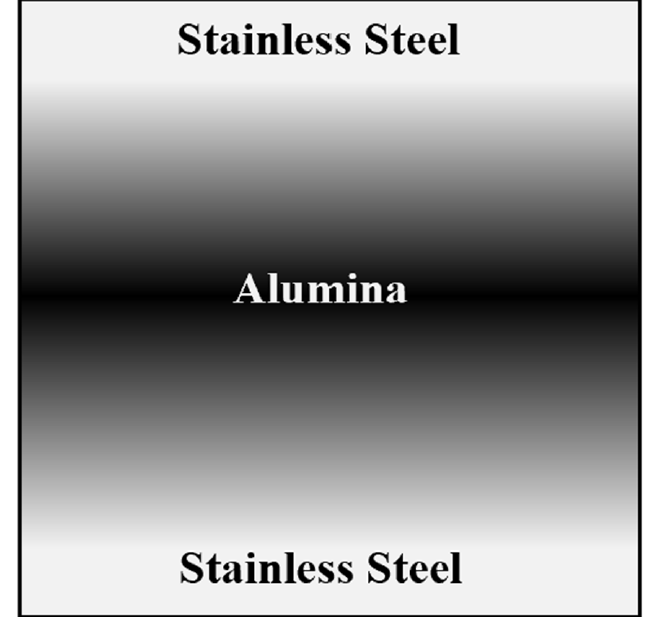
Figure 3. Cross-section of an EG beam. Table 1. Non-dimensional natural frequencies of an exponentially graded beam.